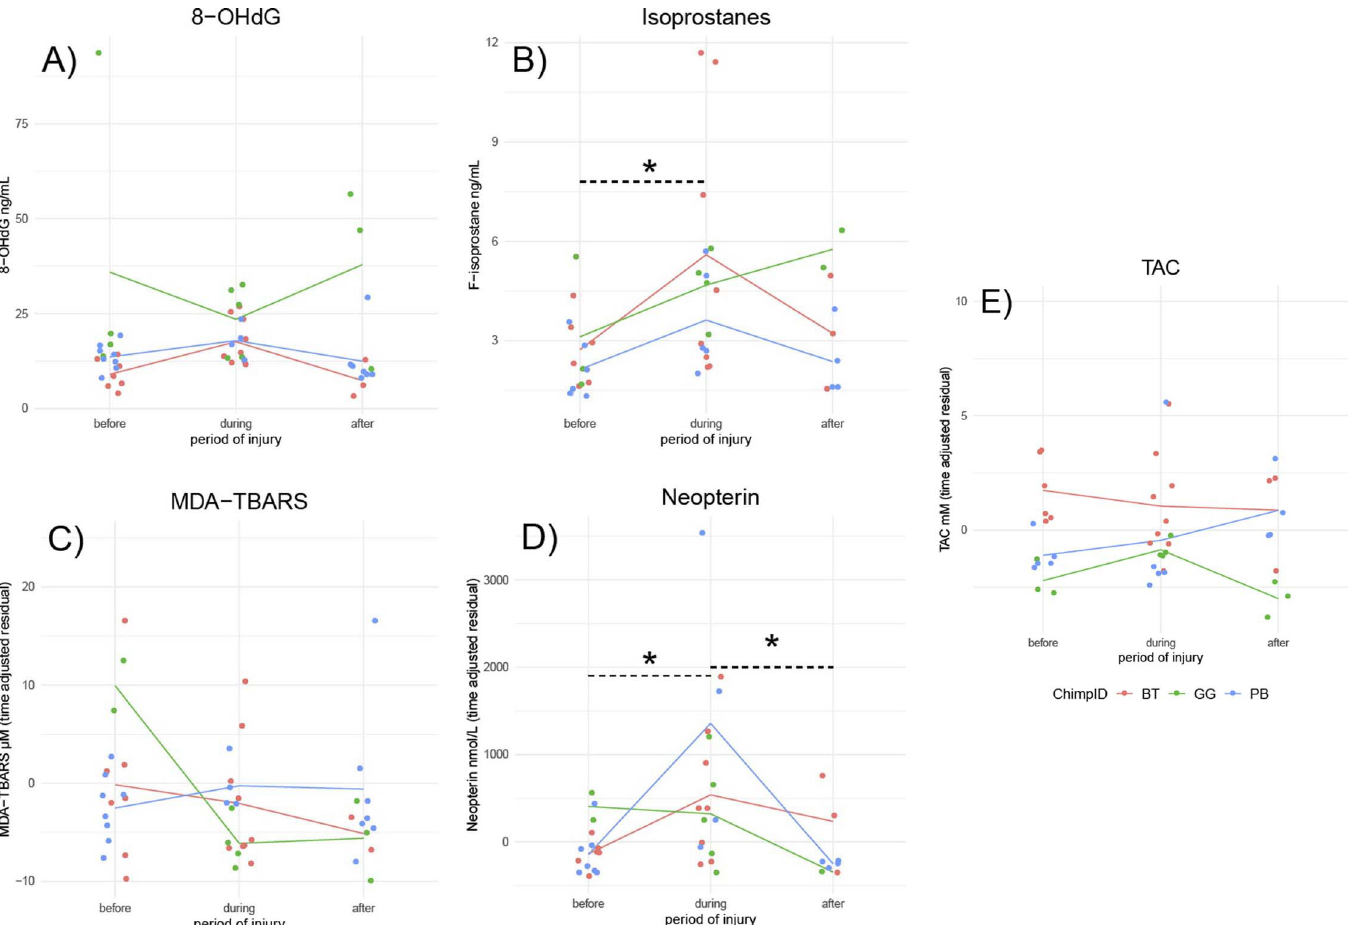
Fig 3. Variation in OS biomarkers according to stage of severe injury. B) Isoprostanes and D) neopterin varied significantly according to periods of before, during, and after severe injury. � Asterisks indicate significant contrasts between periods, as determined by glmer models. For N individuals and samples see S2